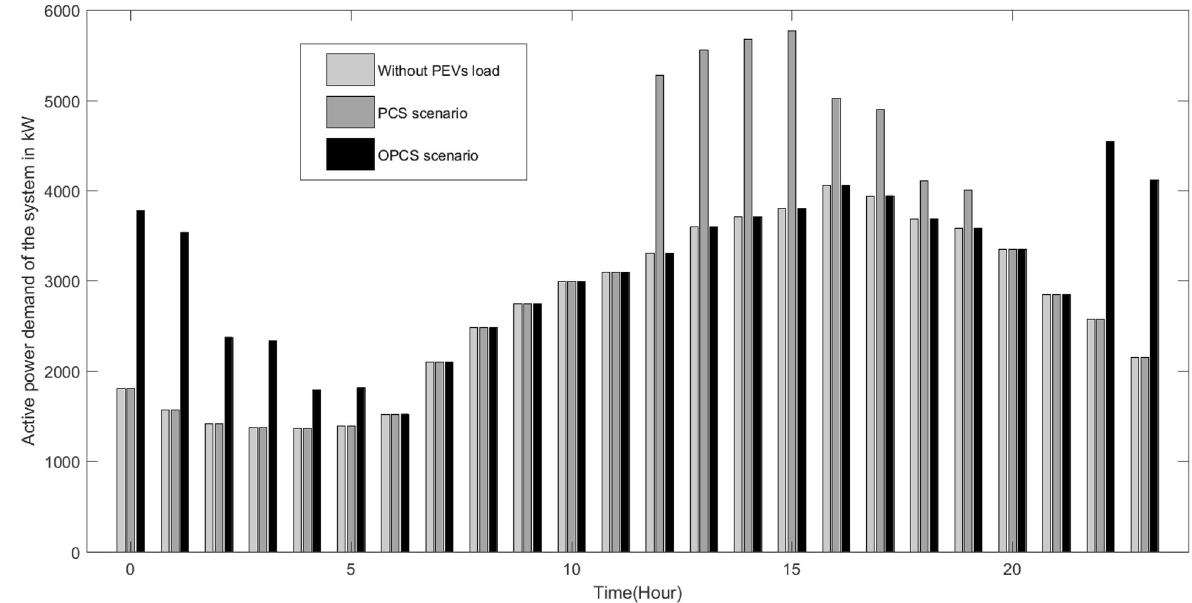
Fig. 5 Hourly active power demand of the system without and with PEVs load